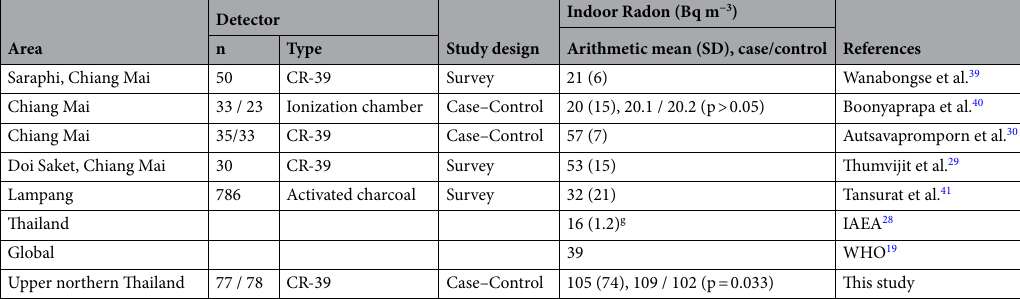
Table 2. Arithmetic means indoor radon concentrations previously reported in upper northern Thailand (UNT). g = geometric mean.